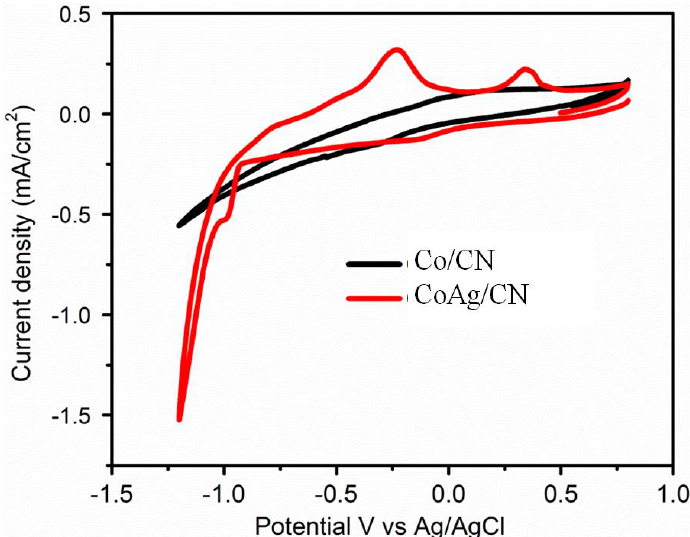
Figure 9. CV Comparison of CoAg / CN and Co / CN in 0.5 M KHCO 3 at a scan rate of 100mV / sec after CO 2 purge.